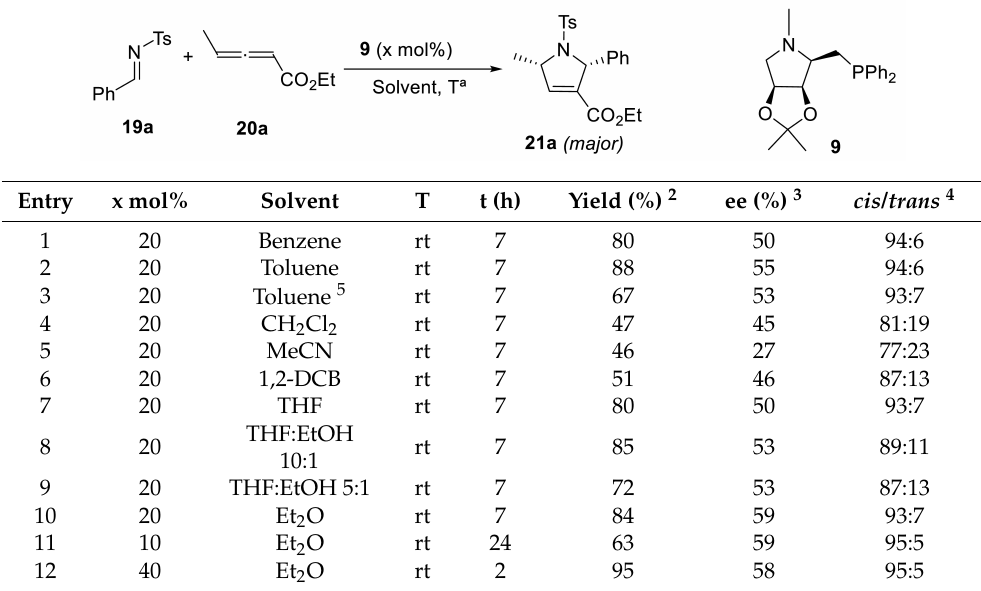
Table 2. Optimization screening for the model reaction 1